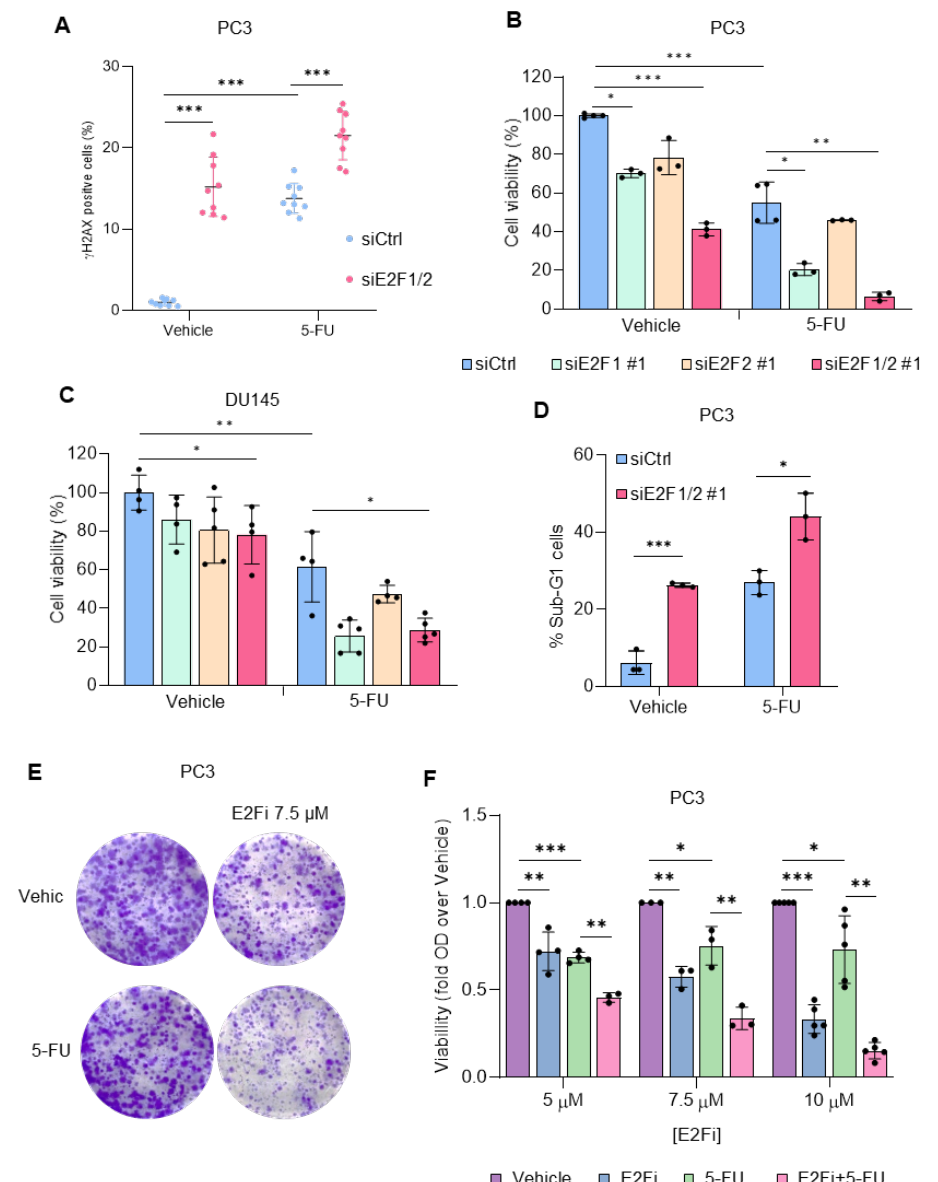
Figure 2. E2F knockdown or chemical inhibition potentiates 5-FU-elicited effects. ( A ) Percentage of γ H2AX-positive cells 72h after transfection with siCtrl or siE2F1/2#1 treated with vehicle or 5-FU during the last 24h. Data from 9 independent experiments are shown. ( B ) Quantification of PC3 cell number using Trypan blue exclusion dye 96 h after transfection with non-target control siRNAs (siCtrl), with siRNAs specific for E2F1 (siE2F1 #1), E2F2 (siE2F2 #1) or for E2F1 and E2F2 (siE2F1/2 #1) and treatment with 5-FU (5 µM) for the last 72h. Results of cell viability are expressed as percentage of viable cells over the siCtrl vehicle sample. ( C ) Quantification of DU145 cell number using Trypan blue 72h after transfection with non-target control siRNAs (siCtrl), with siRNAs specific for E2F1 (siE2F1 #1), E2F2 (siE2F2 #1) or for E2F1 and E2F2 (siE2F1/2 #1) and treatment with 5-FU (5µM) for the last 48h. Results of cell viability are expressed as percentage of viable cells over the siCtrl vehicle sample. ( D ) Percentage of total cells with DNA content compatible with apoptosis 96h after transfection with non-target control siRNAs (siCtrl) or with siRNAs specific for E2F1 and E2F2 (siE2F1/2 #1) and treatment with 5-FU (5 µM) for the last 72h. Data show the average ±SD from 3 independent experiments. ( E ) Colony forming capacity of PC3 cells after treatment with 5-FU and E2Fi. PC3 cells were treated with 5-FU (1 µM) and E2Fi (5, 7.5 and 10 µM) alone or in combination. 72 hours later, drugs were washed out and cells were incubated with fresh media for an additional